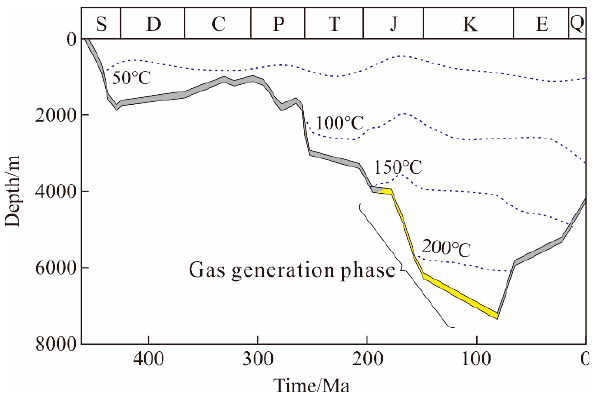
Figure 2. Burial history of Wufeng ‐ Longmaxi shale in Sichuan Basin (modified from Guo et al., 2022 [36]).